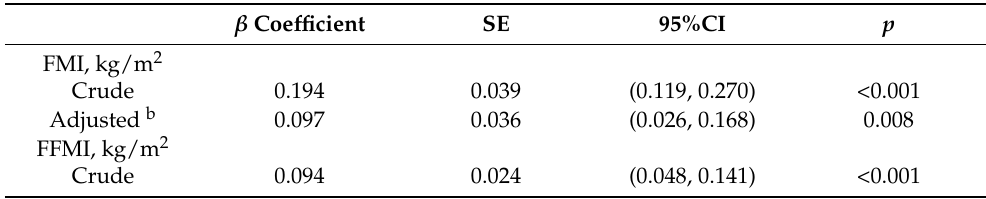
Table 3. Associations of cesarean delivery with repeated anthropometric and body composition measures in kindergarten children (3–6 years) a